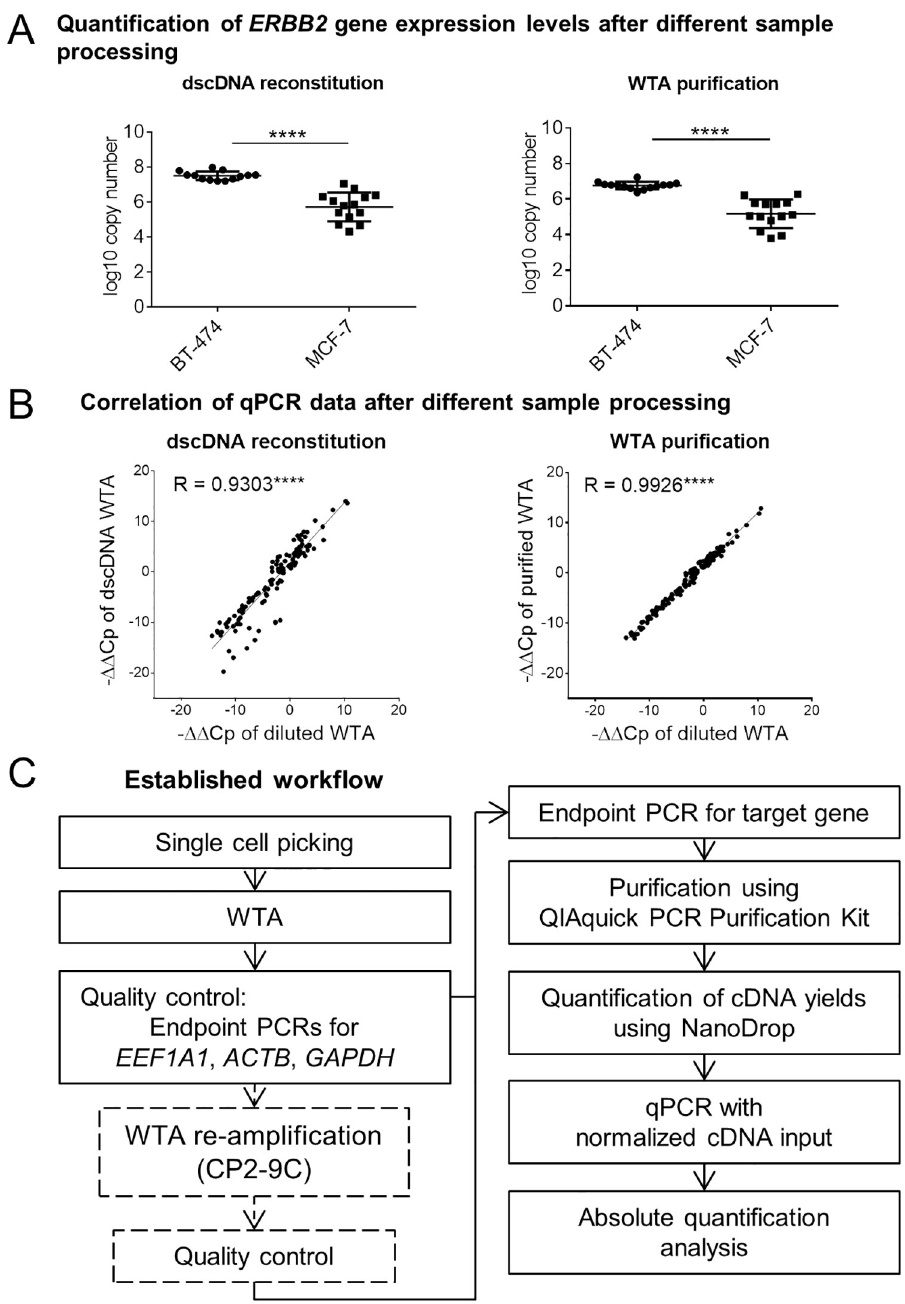
Fig 2. Novel qPCR-based workflow for highly accurate gene expression analysis in single cells. (A) Quantification of the ERBB2 gene expression levels in MCF-7 and BT-474 single cells using absolute qPCR quantification. WTA products underwent either double-stranded cDNA (dscDNA) reconstitution (left panel) or purification using the QIAquick PCR Purification Kit (right panel) prior to the normalization of cDNA input and qPCR. Cp values were converted to log10 copy numbers using an external standard curve. Mean ± SD; Unpaired t-test with Welch’s correction; ���� p < 0.0001. (B) Correlation of ERBB2 expression levels obtained using the relative quantification strategy for the diluted WTA samples as compared to the WTA products subjected to dscDNA reconstitution (left panel) or purification (right panel). Each point represents one - ΔΔ Cp value calculated for one ERBB2 -reference gene pair (- ΔΔ Cp for all target/reference gene combinations were plotted). Pearson’s correlation coefficient R. ���� p < 0.0001. (C) Workflow of the established qPCR assay for profiling gene expression levels in single cells using the absolute quantification